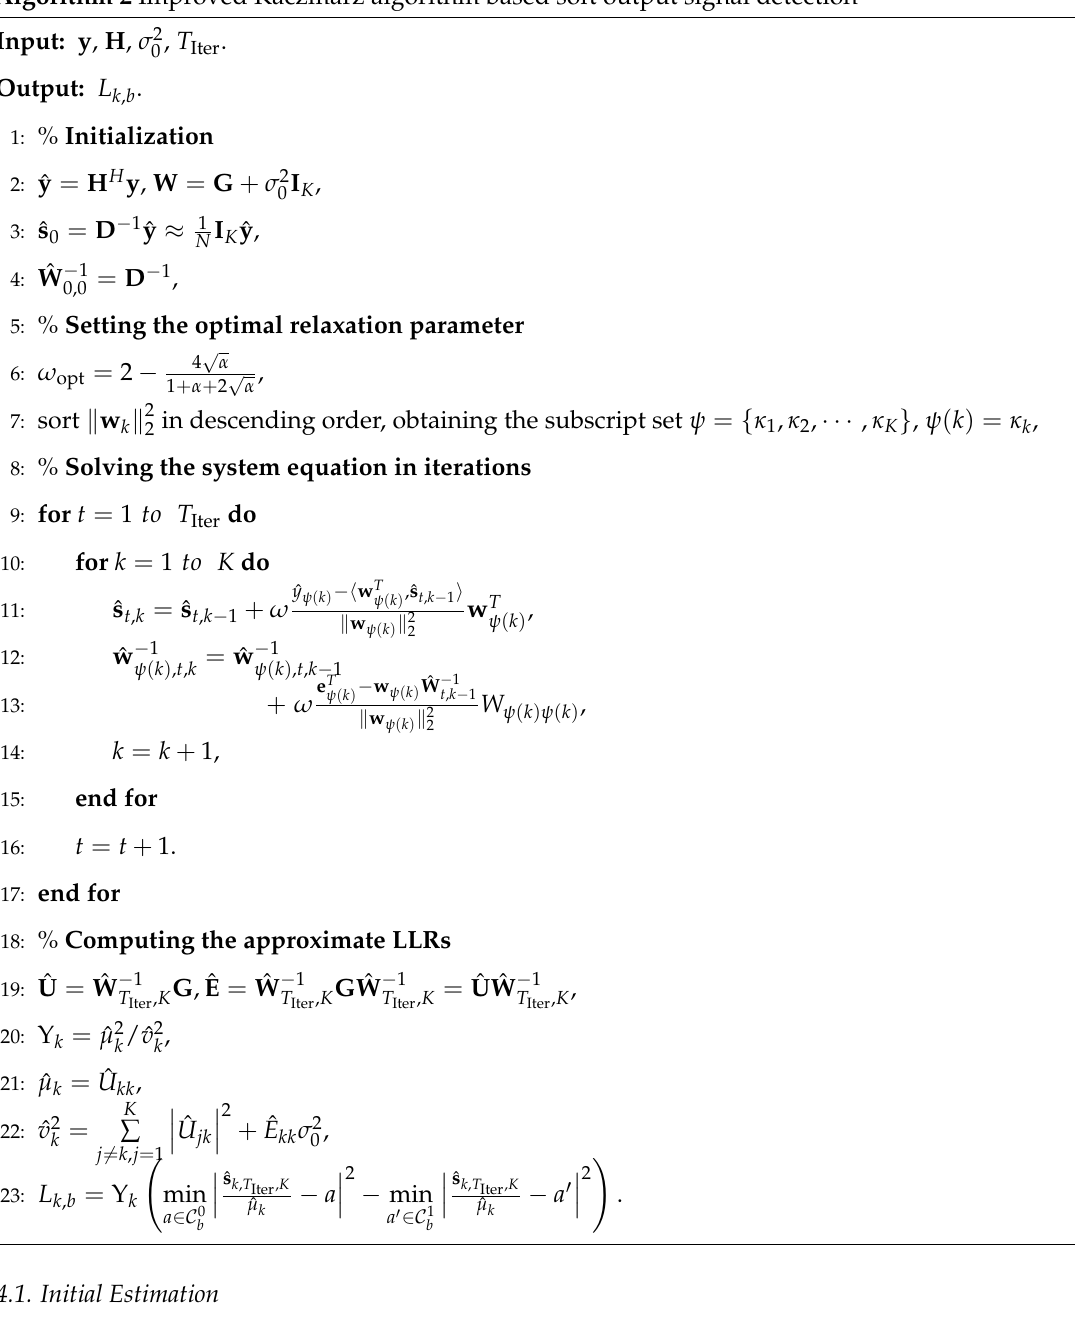
Algorithm 2 Improved Kaczmarz algorithm based soft output signal